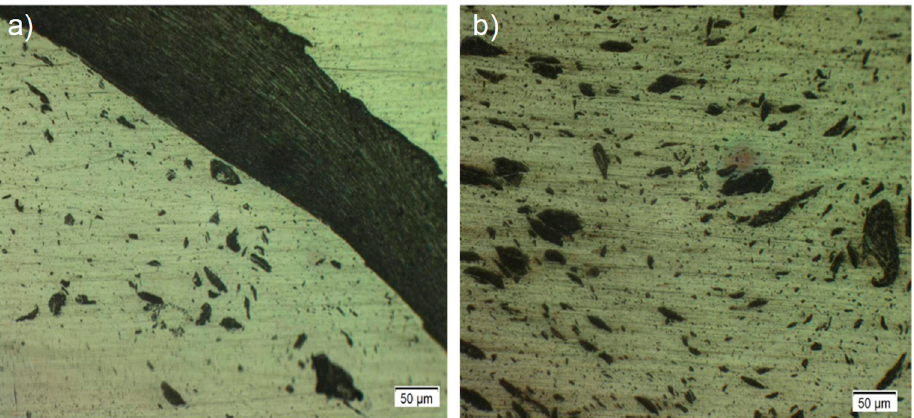
Figure 5. Optical microscopy images for the steel fragment at the Al side: ( a ) mixed small and large size steel fragments and ( b ) small size steel fragments.